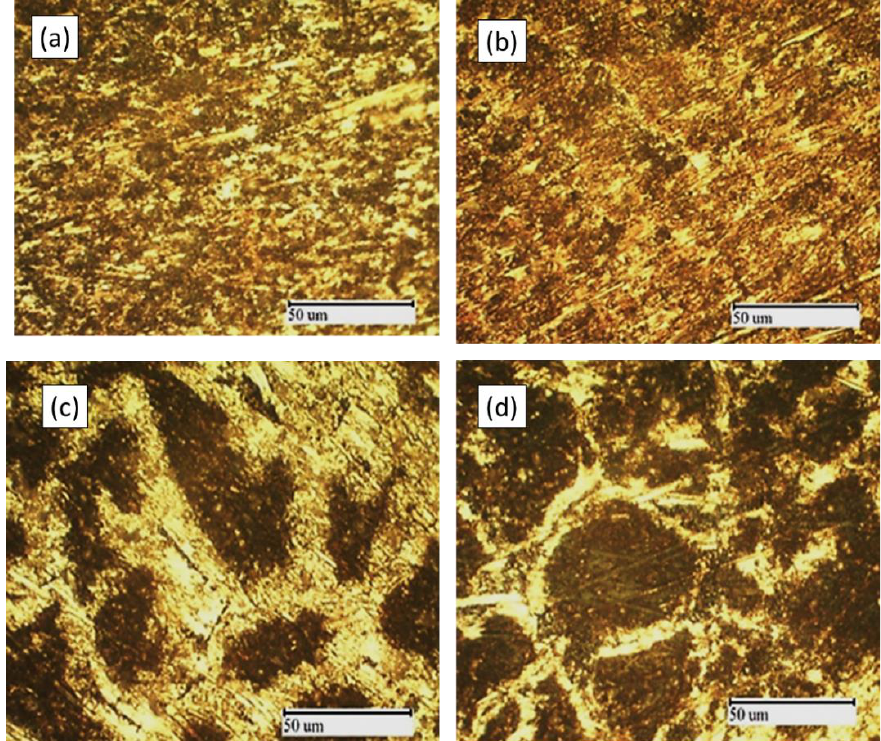
Figure 3: Plate 1: Microstructure of the 6xxx aluminium alloy under different cooling rates (a) mould was cooled at room temperature (b) mould was cooled in ice block (c) mould was cooled mould temperature 430 o C (d) mould was cooled at 230 o